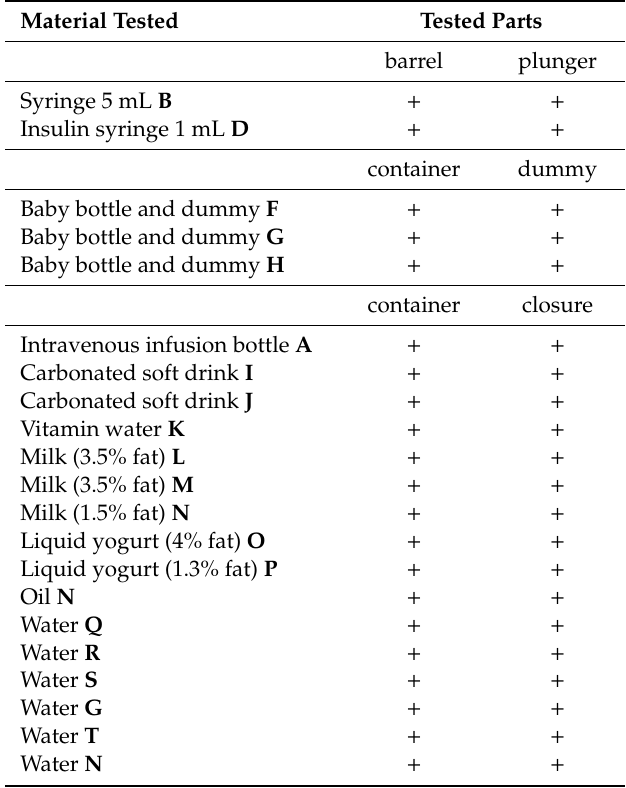
Table 2. Material parts tested for oleamide